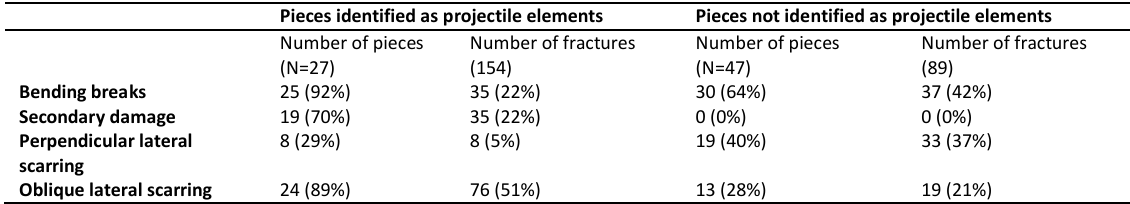
Table 8. Overview of the representation of the four fractures categories in the sample of indentified projectile in comparaison with the rest of the curved backed point sample from LB25 locus.